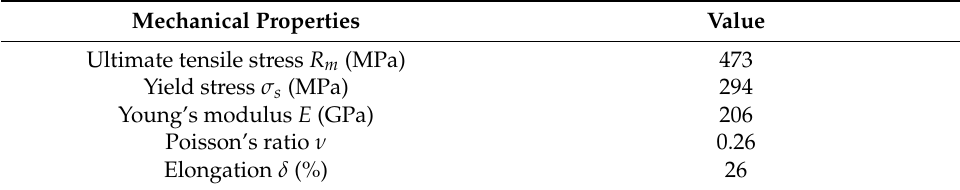
Figure 2. The experimental ship hatch corner specimen. Table 1. Mechanical properties of Q235B